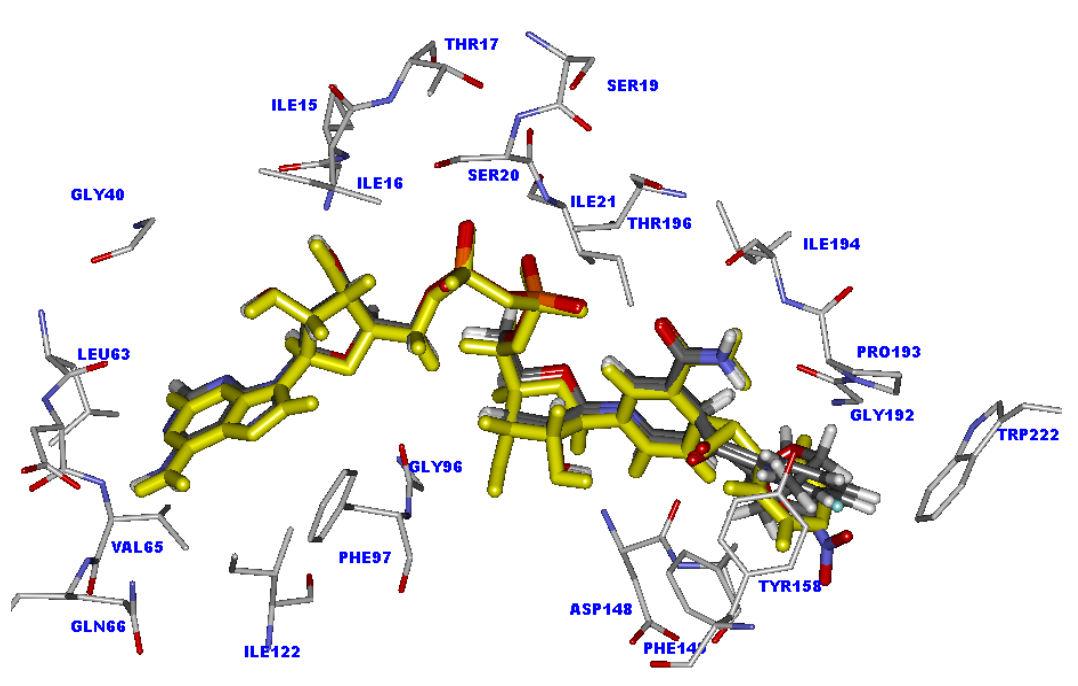
Figure 3. Superimposition of the INH-NAD adduct (colored by yellow) and compounds 2- 7 (colored by atom type) in InhA binding pocket obtained from molecular docking